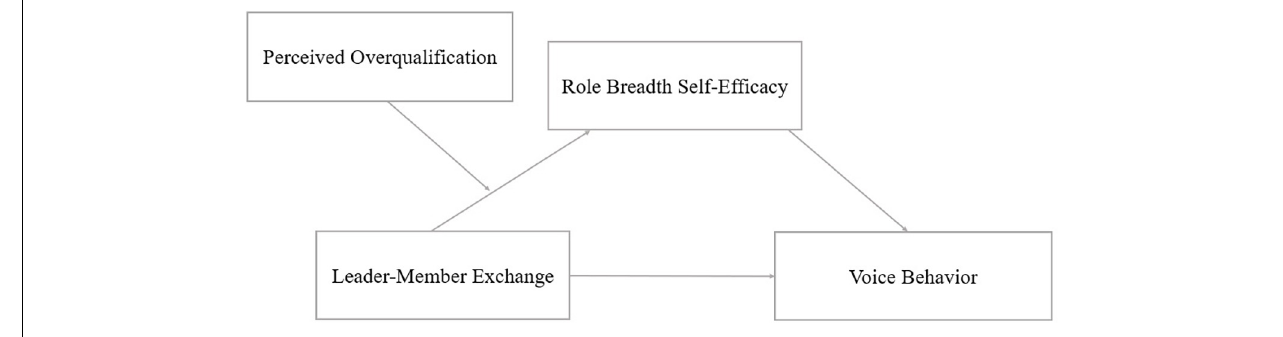
FIGURE 1 | Theoretical